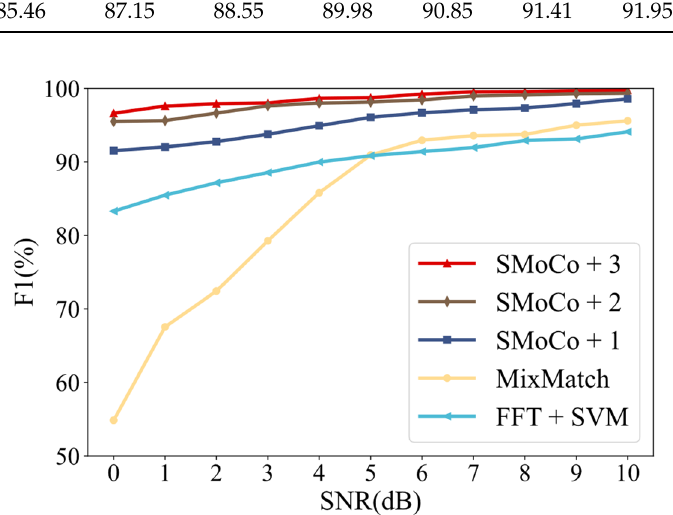
Figure 19. Experimental results of the sensitivity to the SNR on the aero-engine bearing dataset.